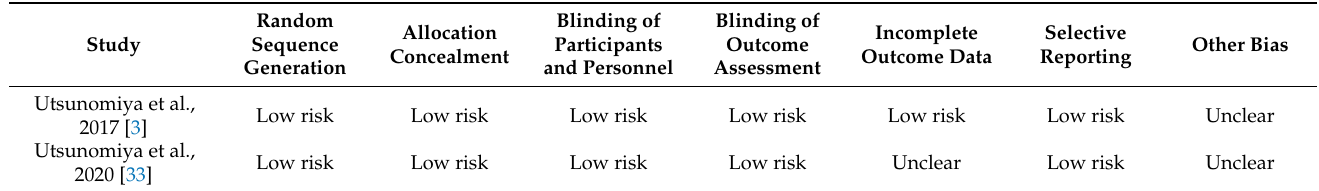
Table 3. Risk of bias assessment for randomized controlled trials.